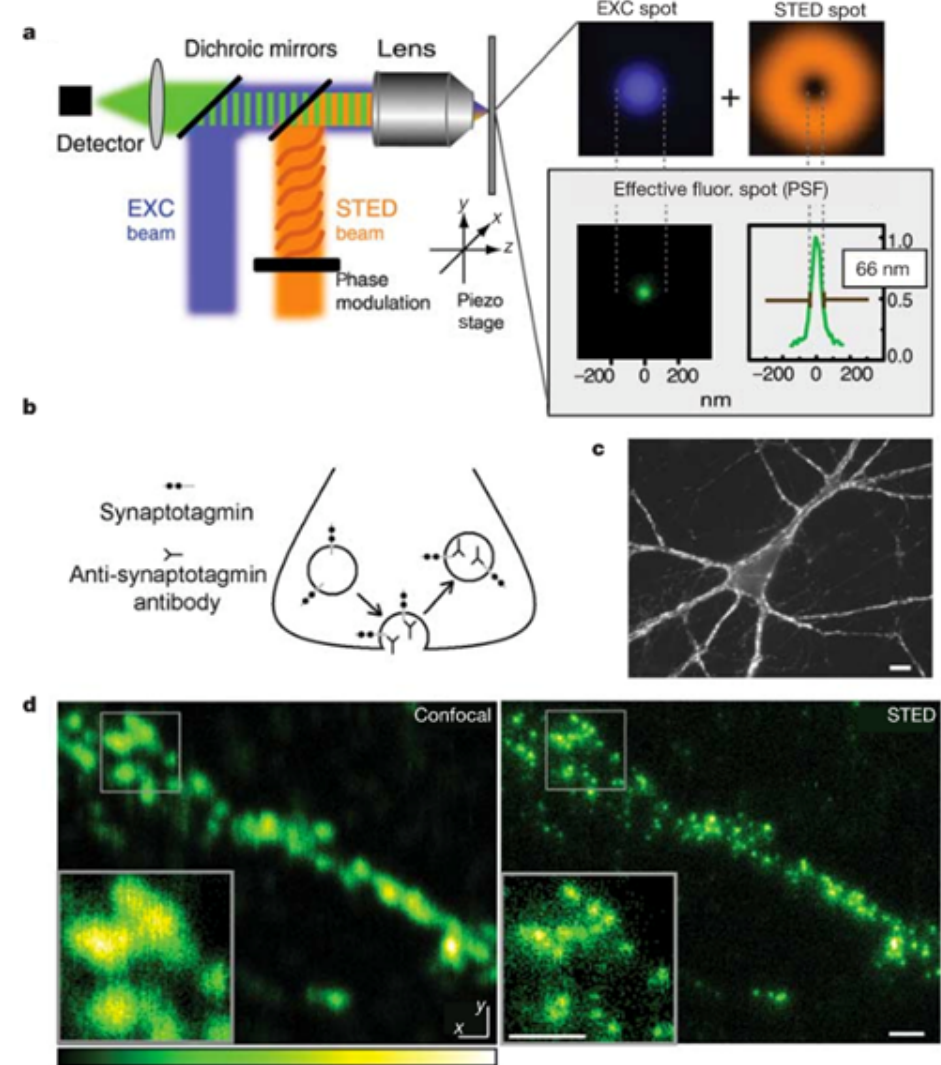
shown in the adjacent panel in blue, the orange STED beam is able to de-excite molecules. The STED beam is phase-modulated to form the focal dounut shown in the top right panel. Superimposition of the two focal spots confines the area in which fluorescence is possible to the dounut center, yielding the effective fluorescent spot of subdiffraction size shown in green in the lower panel. All spots represent measured data and are drawn to scale. The profile of the green effective fluorescent spot has a full width at half maximum of 66 nm as well as a sharp peak. The green spot shows an 11-fold reduction in focal area beyond the excitation diffraction value (compare with blue spot). ( b ) Mechanism of synaptic labeling. Synaptic vesicles exocytose, allowing their lumenal synaptotagmin domains to bind anti-synaptotagmin antibodies. These antibodies are internalized upon endocytosis. ( c ) Typical image of a neuron labeled with an anti-synaptotagmin antibody, fixed, permeabilized, and visualized by using Atto532-labeled secondary antibodies. Fluorescent puncta represent labeled synaptic nerve terminals. Scale bar = 10 mm. ( d ) Comparison of confocal (left) and STED (right) counterpart images of a labeled preparation reveals a marked increase in resolution by STED. Scale bar = 500 nm. PSF, point spread function. Taken from